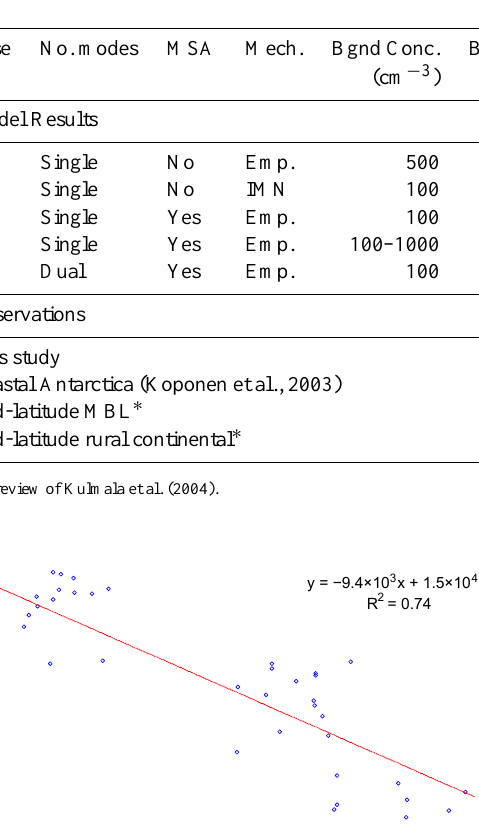
Table 2. Formation and growth rates found experimentally (top) and from the model (bottom). For each model case (changes to the number of modes, the inclusion of MSA and the mechanism, where “Emp.” refers to the empirical mechanism and “IMN” is ion-mediated nucleation), the parameters and results shown in the table represent the best approximation of observations. Only one case (d) produced values that were representative of observed values; however, this is unrealistic because it represents an environment free from background aerosol, essentially removing precursor scavenging. Parameter values common to all model simulations present include [OH] = 5 × 10 6 moleccm − 3 and A = 1 × 10 − 8 s − 1 .